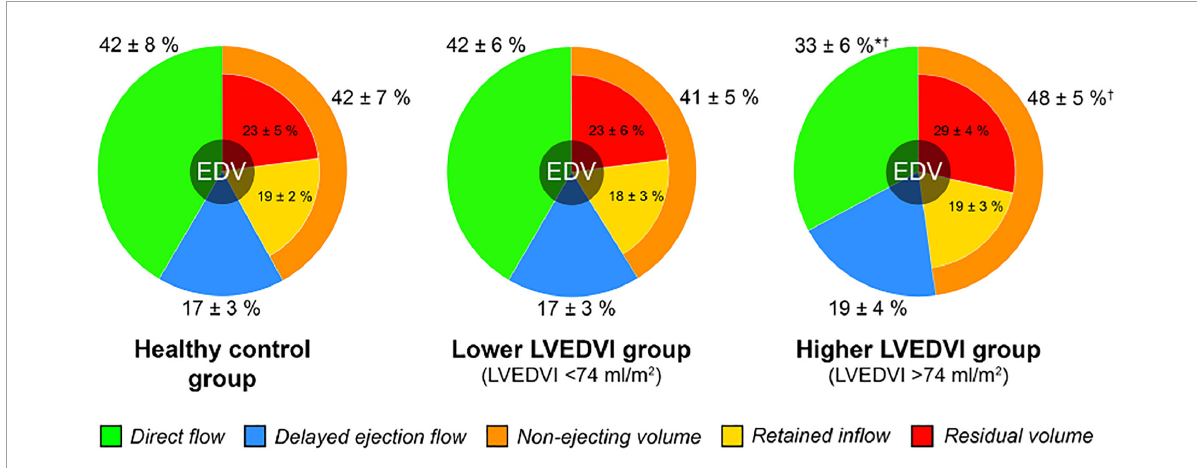
FIGURE8 Left ventricular blood flow component distribution in healthy controls and in chronic ischemic heart disease patient subgroups (stratified by LVEDV index)